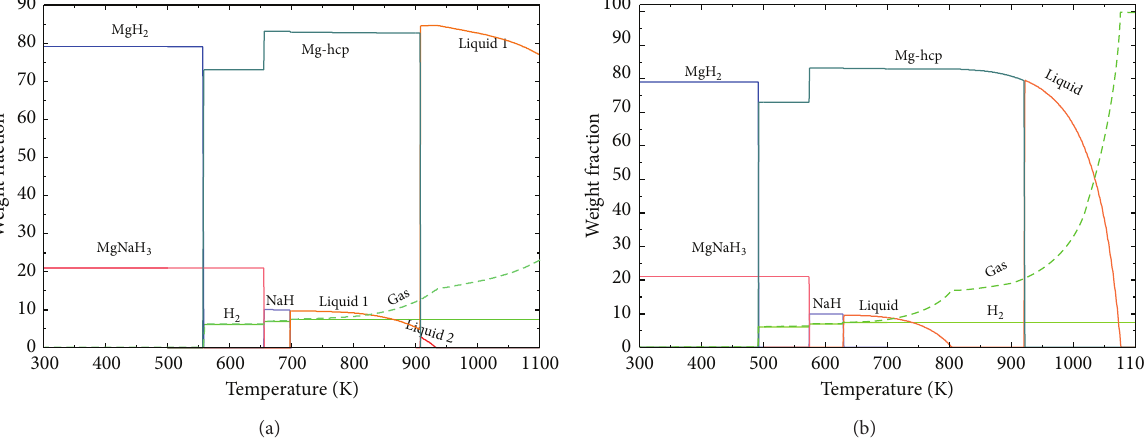
Figure 15: Calculated reaction path for MgH 2 + 10wt.% NaH at (a) 1 bar and (b) 0.1